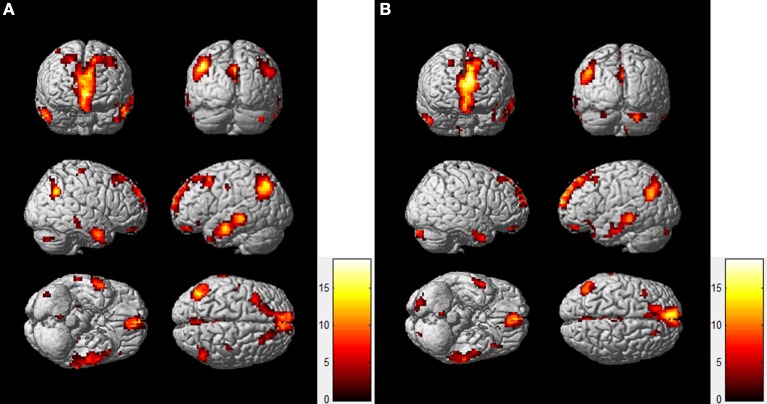
DMN Maps of the resting-state (A) and task-state (B).